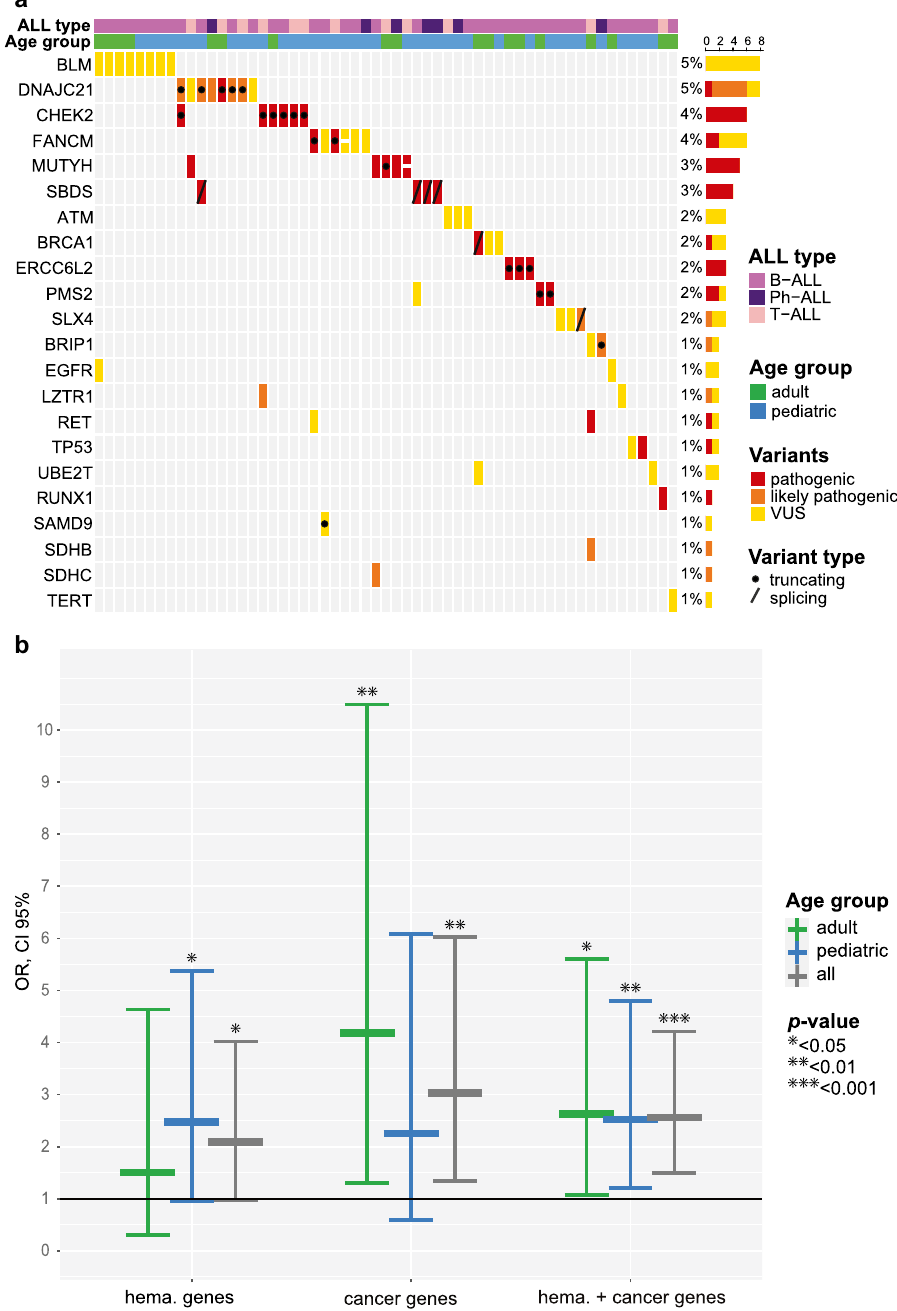
Figure 1. ( a ) The distribution of all pathogenic and likely pathogenic variants and variants of uncertain significance (VUS) in the ALL patients. The frequency and number of patients harboring a variant in each gene are shown on the right-hand panel. B-ALL, Ph-negative B-ALL; Ph-ALL, Ph-positive B-ALL. ( b ) Enrichment of pathogenic variants in ALL patients compared to healthy controls (gnomAD Finns). Variants in genes with known predisposition to hematological malignancies (n = 93) and other known cancer-predisposition genes (n = 70) are shown separately and together for both age groups and overall. OR, odds ratio; CI, confidence